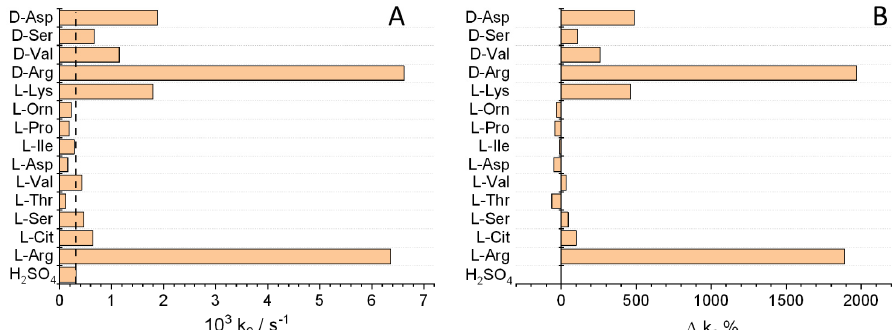
Figure 4. Bar graph of ( A ) the values for the not-catalyzed rate constant k 0 for the aggregation of TPPS 4 induced b000y H 2 SO 4 in the presence of amino acids (the dashed black line mark the reference value obtained in the absence of added amino acids); ( B ) the percent deviation of k 0 with respect to the reference value measured in the presence of H 2 SO 4 only.